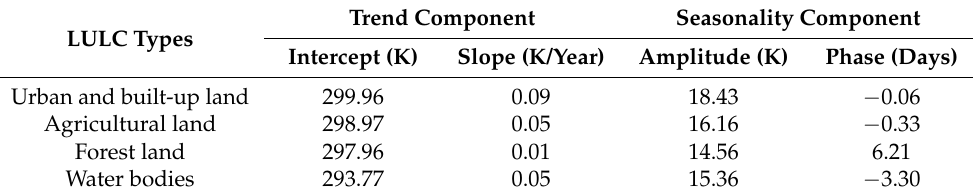
finding shows that the average LST, increasing speed of LST, and annual LST change in urban and built-up land were higher than those in other land cover types. Table 8. The trend and seasonality components of mean LSTs of each LULC type. Trend Component Seasonality Component LULC Types Intercept (K) Urban and built-up land Agricultural land Forest land 297.96 Water bodies (3) Distribution of harmonic terms of LST of different LULC types The normalized histogram distribution of the three main harmonic terms (intercept, slope, and amplitude) of LST for different LULC segments is displayed in Figure 17. Meanwhile, the mean and variance values of the main harmonic terms of LST of four LULC types are presented in Table 9. As a result, the mean and variance values of the intercept term of LST of four LULC types are 301.64 K, 300.18 K, 298.77 K, 294.90 K, and 2.88 K, 1.92 K, 5.13 K, 3.03 K, respectively. In addition, the mean and variance values of the slope term of LST of four LULC types are 0.105 K/year, 0.016 K/year, 0.003 K/year, 0.013 K/year and 0.194 K/year, 0.154 K/year, 0.367 K/year, 0.149 K/year, respectively. Further, the mean and variance values of the amplitude term of LST of four LULC types are 20.42 K, 17.49 K, 15.61 K, 17.03 K, and 1.90 K, 1.29 K, 1.66 K, 1.14 K, respectively. This finding also indicates that the average LST, increasing speed of LST, and annual LST change in urban areas were higher than those in other land cover types. Table 9. The mean and variance value of the main three harmonic terms. LULC Types